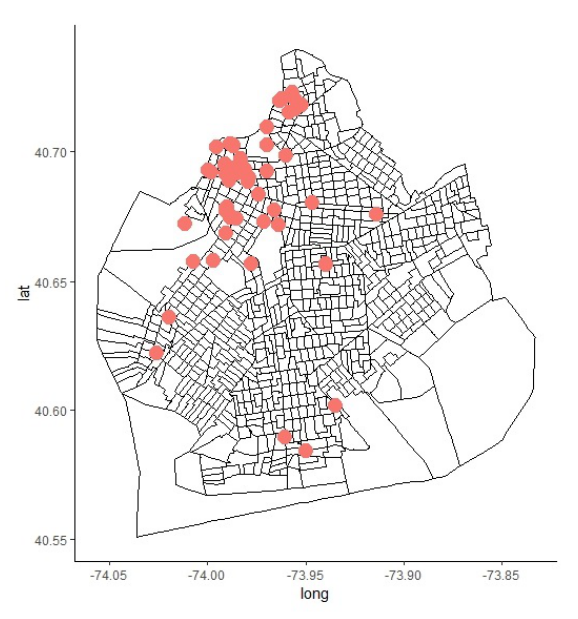
Figure 2. Charging stations in Brooklyn, New York